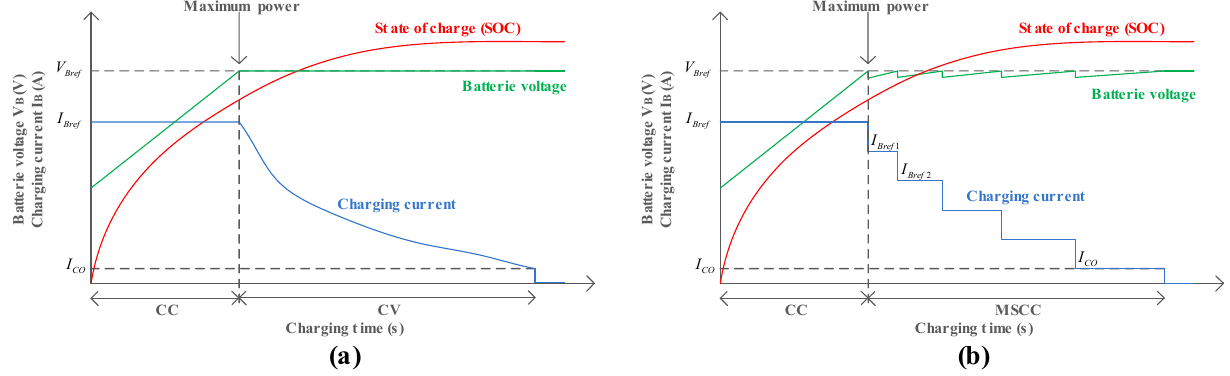
Figure 2. Fast charging methods: ( a ) CC-CV charging method; ( b ) MSCC method.